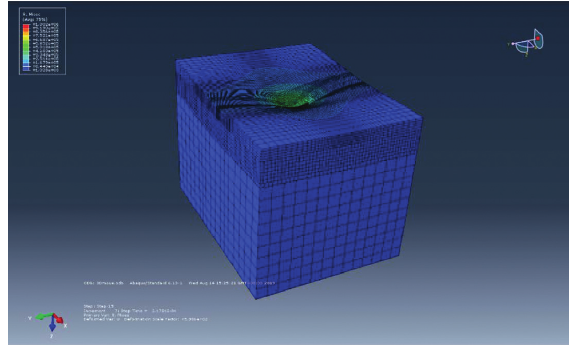
Figure 5: 3-Dimensional pavement model subjected to moving load.